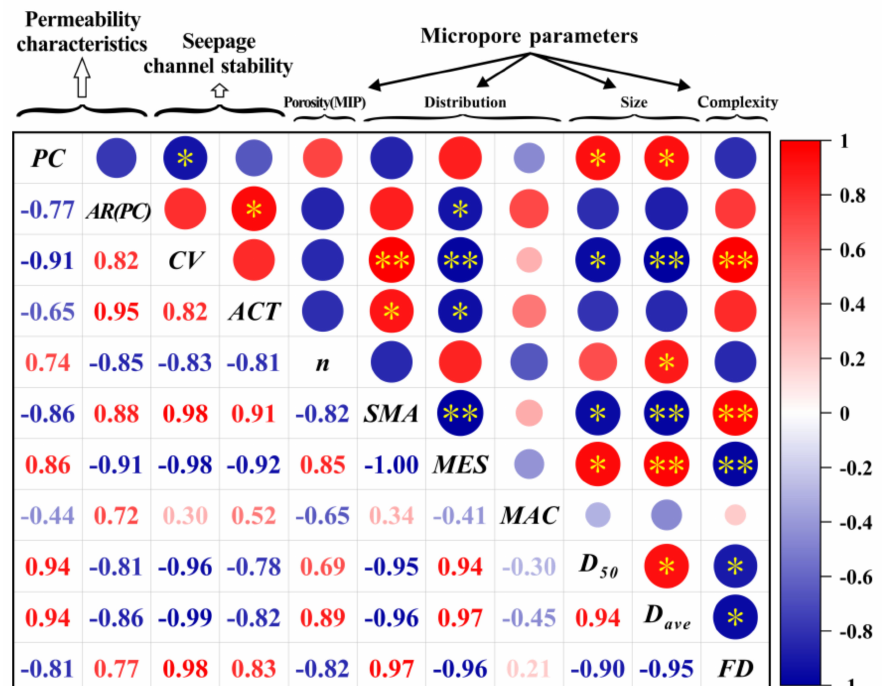
Figure 15. Correlation between permeability characteristic parameters and pore characteristic param- eters. Note: PC, permeability coefficient; AR(PC), attenuation rate of permeability coefficient; CV, coefficient of variation; ACT, average cycle time; n, porosity (MIP); SMA, small pores content; MES, mesopores content; MAC, macropores content; D 50 , medium entrance pore diameter; D ave , average pore diameter; FD, fractal dimension. Significance levels are * <0.05 and ** < 0.01.